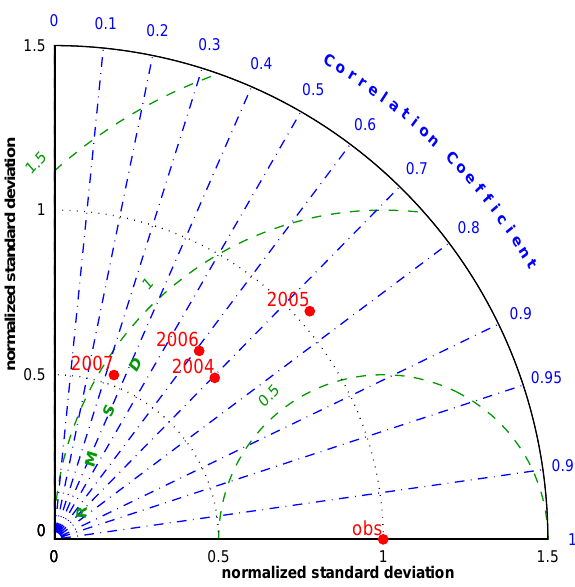
Fig. 3. Taylor Diagram for domain-averaged surface chlorophyll Figure 3. Taylor Diagram for domain-averaged surface chlorophyll concentrations 790 concentrations from 2004 to 2007. Radial distance represents the from 2004 to 2007. Radial distance represents the ratio of simulated to observed 791 ratio of simulated to observed standard deviations, and azimuthal standard deviations, and azimuthal angle represents model-data correlation. Green 792 angle represents model-data correlation. Green arcs represent cen- arcs represent centered root mean square difference between model and data. 793 tered root mean square difference between model and data.